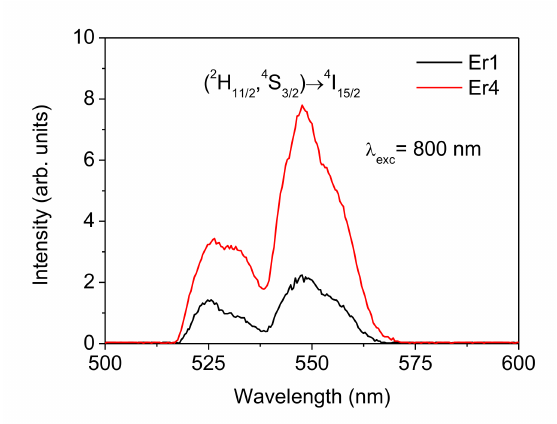
Figure 6. Upconversion emissions at room temperature for Er 3+ ions in aluminosilicate glasses under excitation at 800 nm.